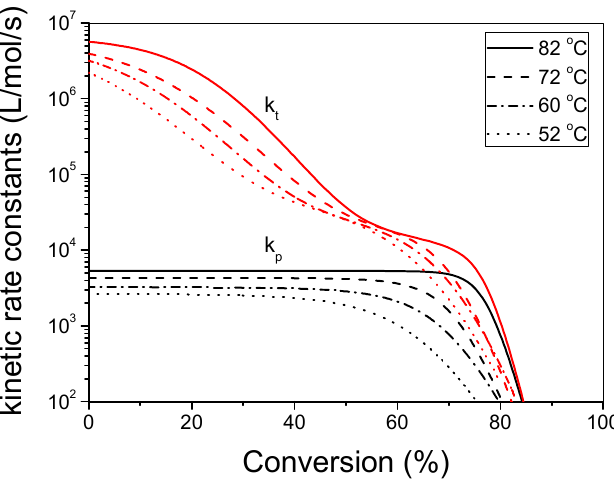
Figure 3. Variation of the termination and propagation rate constants estimated from Equations (5) and (6) with conversion at several reaction temperatures, using the parameters reported in Table 1.